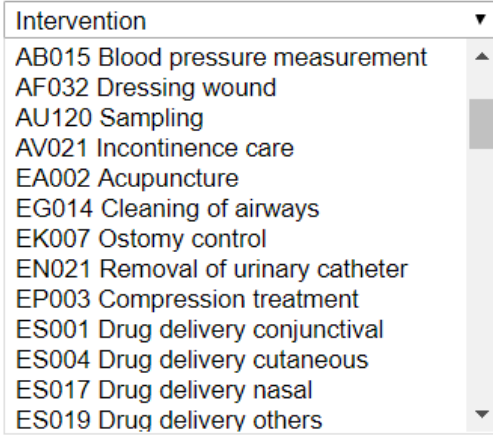
Figure 1. An illustration of a drop-down menu with interventions sorted by code and not by name. The user must scroll through the list to find the desired